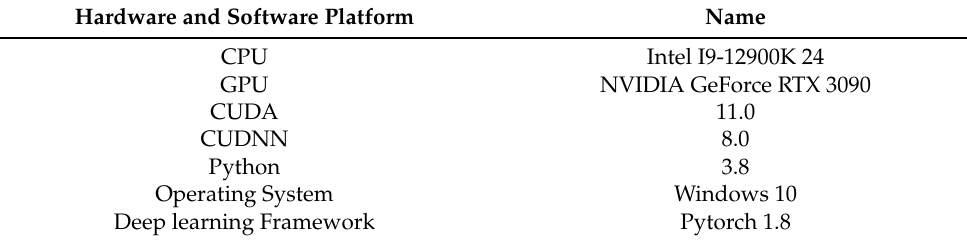
Table 1. Software and hardware platforms and their corresponding